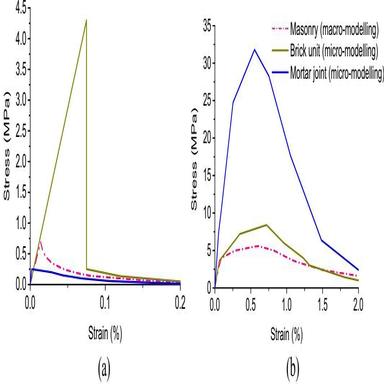
Mechanical properties of masonry numerically modelled for (a) tension (b) compression.